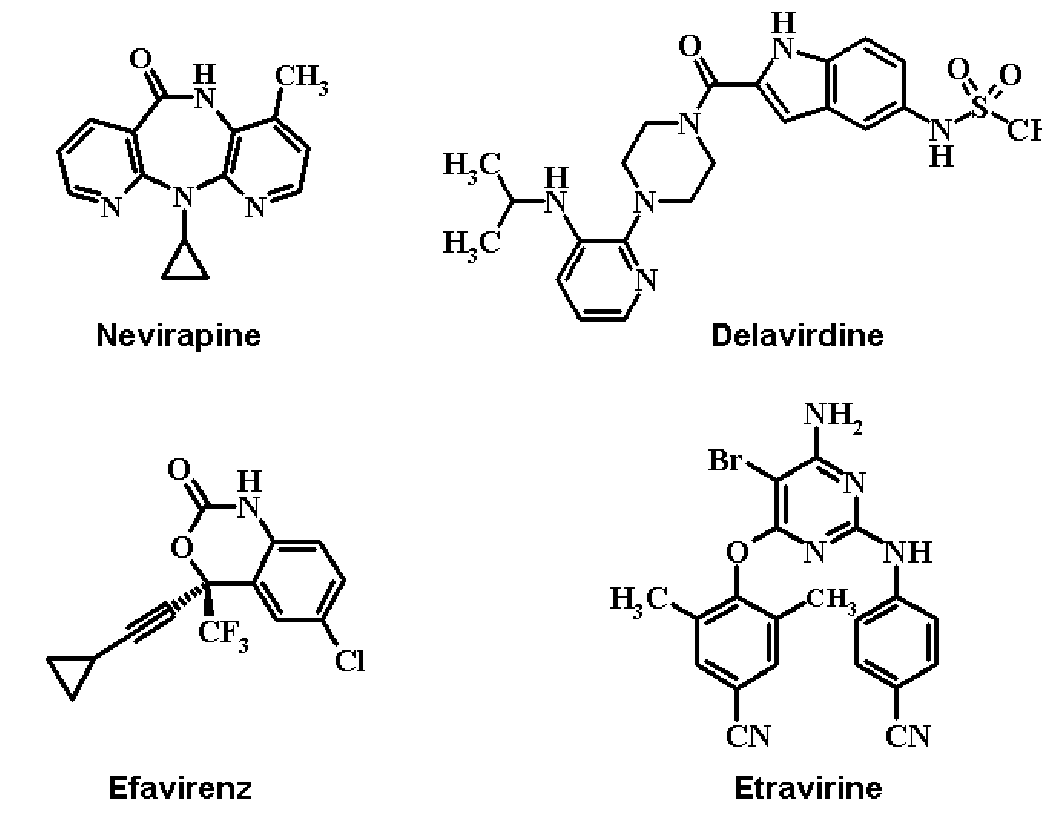
Figure 1. Structures of the four non-nucleoside reverse transcriptase inhibitors (NNRTIs), nevirapine, delavirdine, efavirenz, and etravirine, approved by the US Food and Drug Administration (FDA) to treat